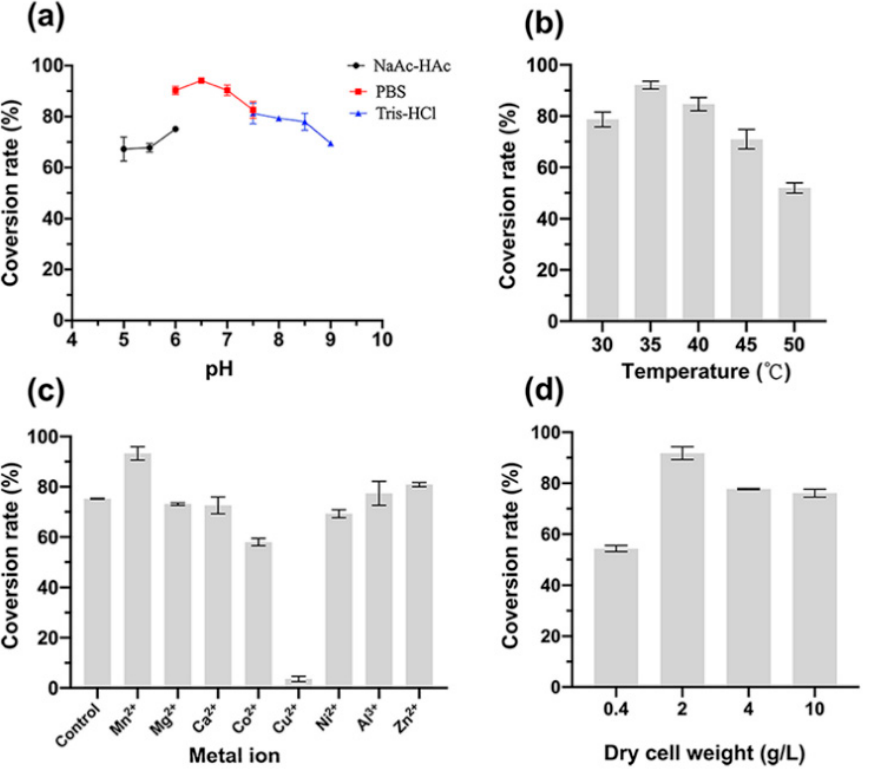
Figure 3. Effect of pH ( a ), temperature ( b ), metal ions ( c ), and dry cell weight ( d ) on the conversion rate of MDH-FDH whole-cell.